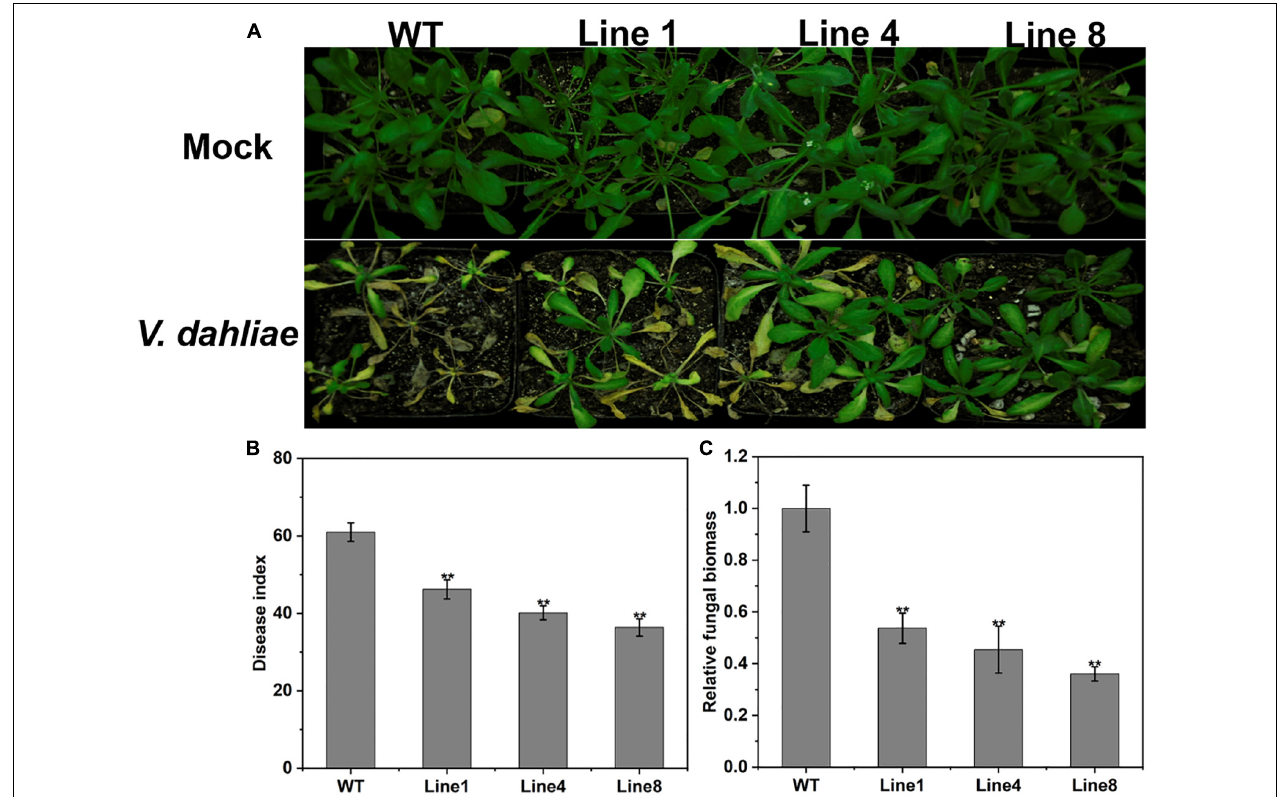
FIGURE 7 | Increased resistance to Verticillium dahliae in GhPLP2 -overexpressed Arabidopsis. (A) Arabidopsis plants were inoculated with sterile water and V. dahliae by root dipping, respectively. Images were taken at 14 dpi. (B) Disease index at 14 dpi. Data represent the means ± standard error of three independent technical replicates. Asterisks indicate a significant difference compared with the WT. ( **P < 0.01, Student’s t -test). (C) The fungal biomass of Arabidopsis plants at 14 dpi. Data represent the means ± standard error of three independent biological replicates. Asterisks indicate a significant difference compared with the WT. ( **P < 0.01, Student’s t